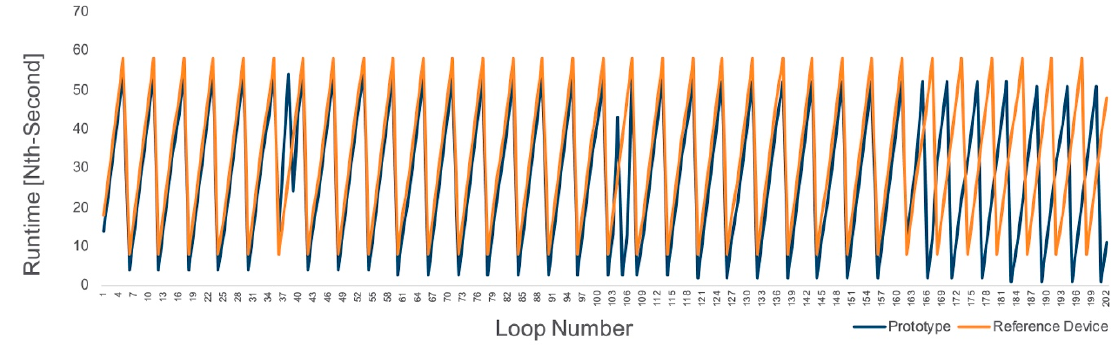
Figure 22. Validation graph for data logger.